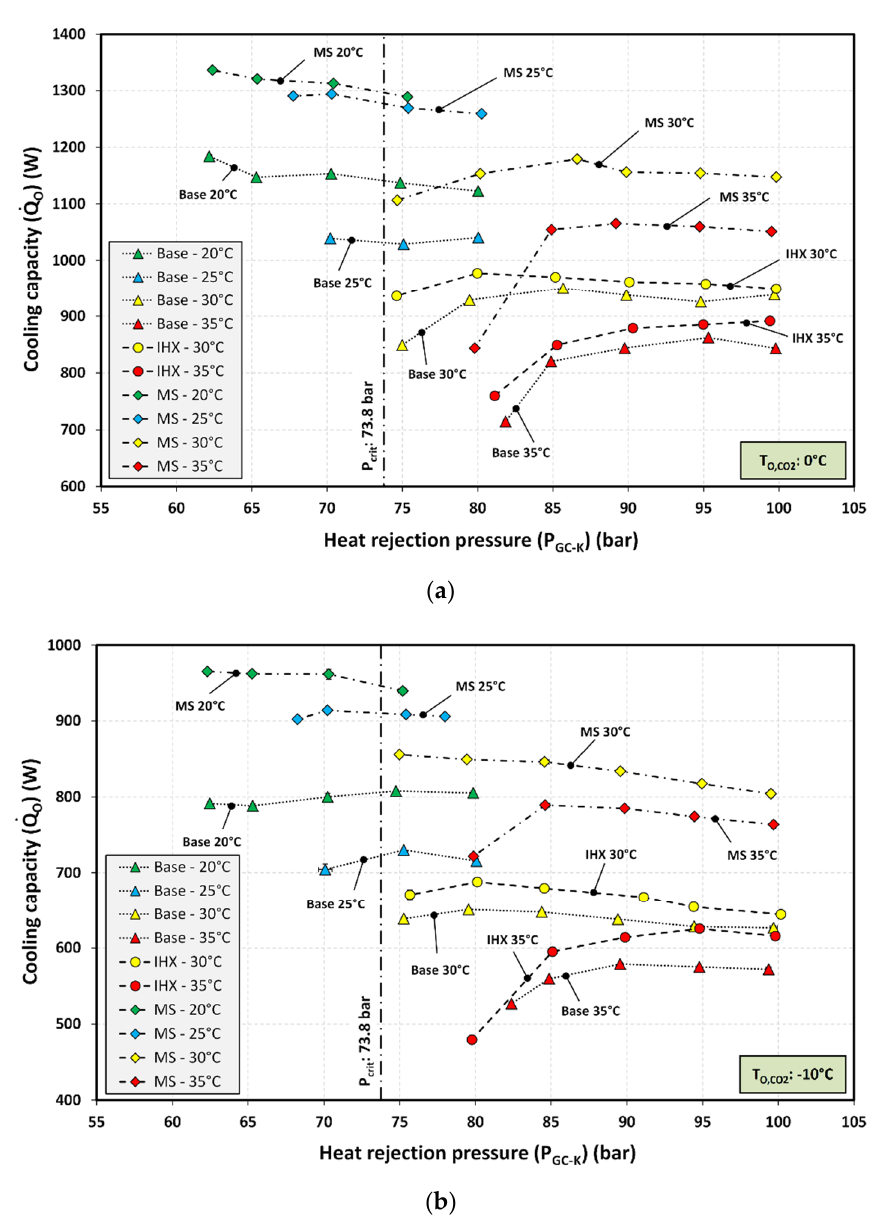
Figure 5. Average cooling capacity ( Q̇ (cid:2899) ) of the refrigerating plant at 0°C ( a ) and −10 °C ( b ). 3.4. COP